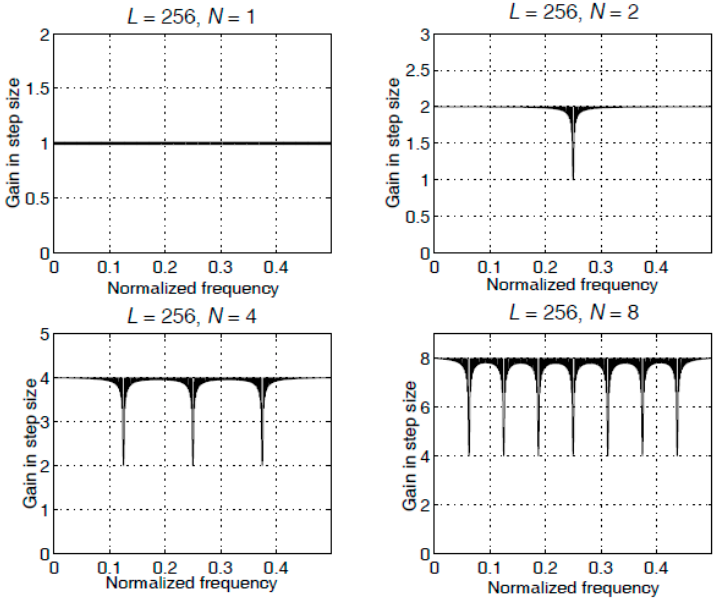
Figure A4. Gain in step-size for a single tone and different decimation factors, N = 1, 2, 4, and 8. The length of the filter is set to L = 256 taps.